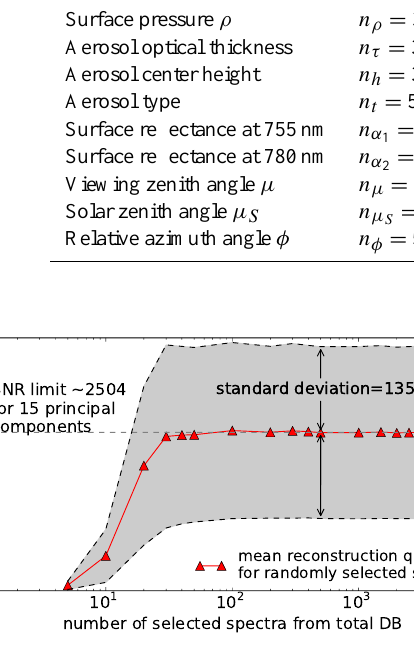
Fig. 3. Histograms of the reconstruction SNR for various sample